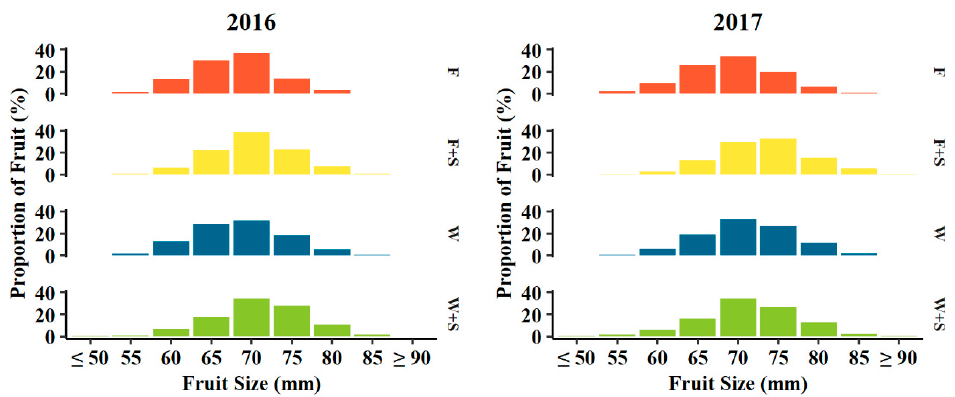
Figure 4. Histogram of proportion of fruit (%) in fruit size (mm) categories determined at harvest of 2016 ( left ) and 2017 ( right ) fruit grown among seasonal pruning treatments consisting of fall pruning (F, orange, n = 1262 and 1849 in 2016 and 2017, respectively), fall and summer pruning (F + S, yellow, n = 1072 and 1086 in 2016 and 2017, respectively), winter pruning (W, blue, n = 856 and 1019 in 2016 and 2017, respectively), and winter and summer pruning (W + S, green, n = 797 and 818 in 2016 and 2017,